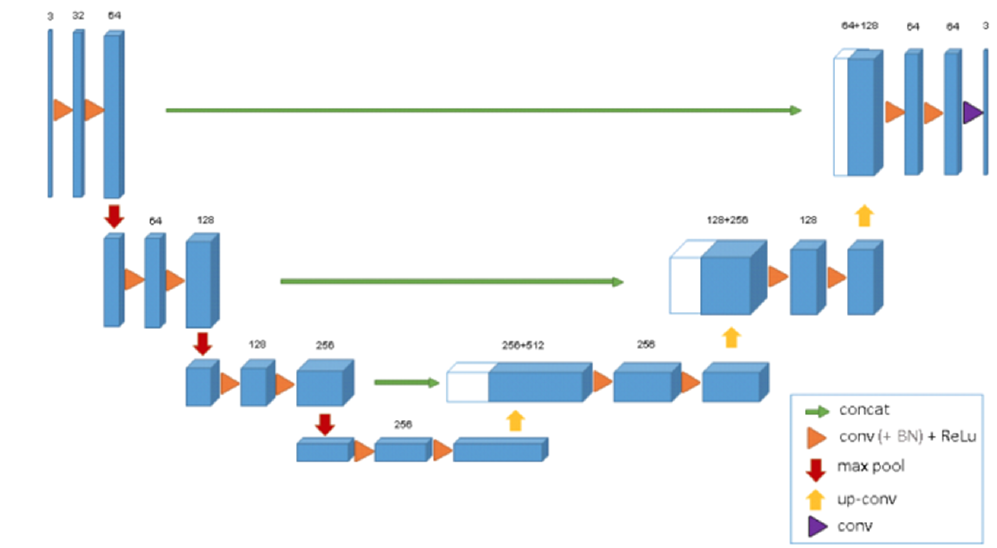
Figure 2. Structure of the 3D U-Net.